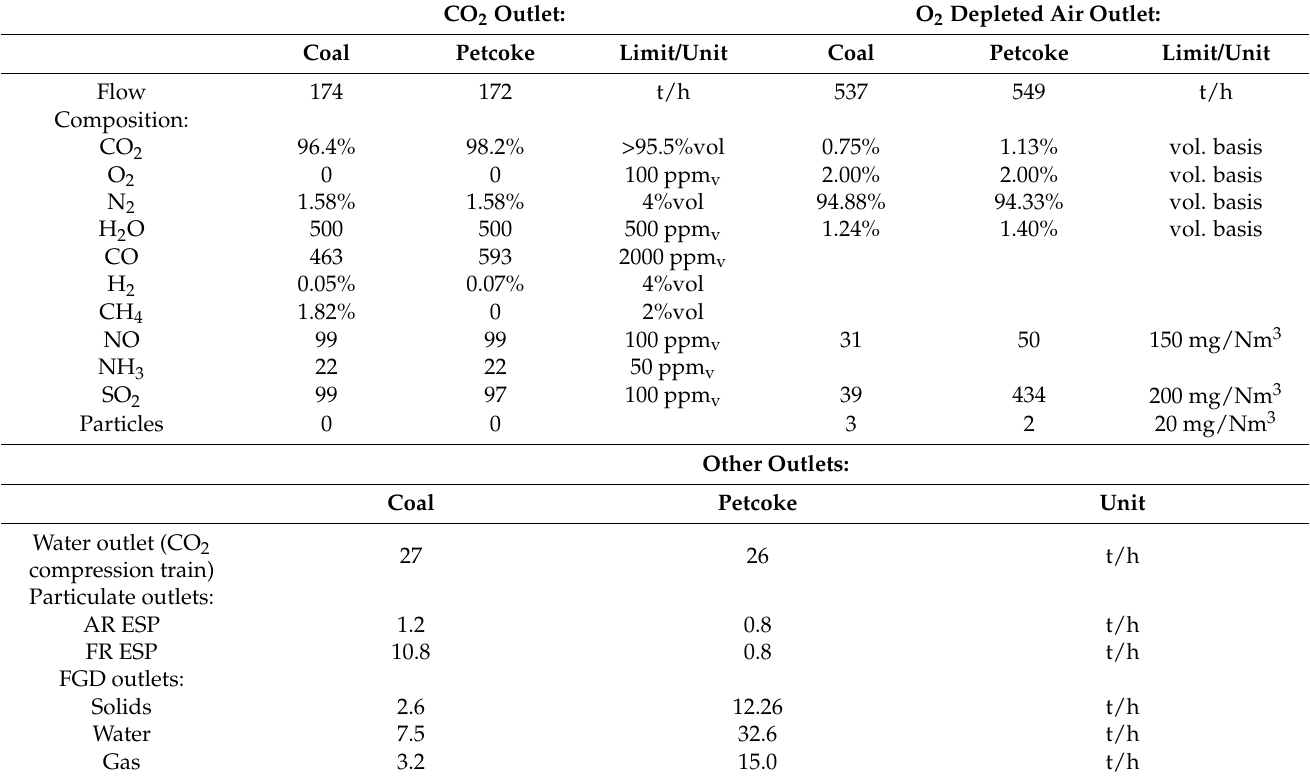
Table 6. Calculated processes outlets (after the gas cleanup units for the CO 2 and air